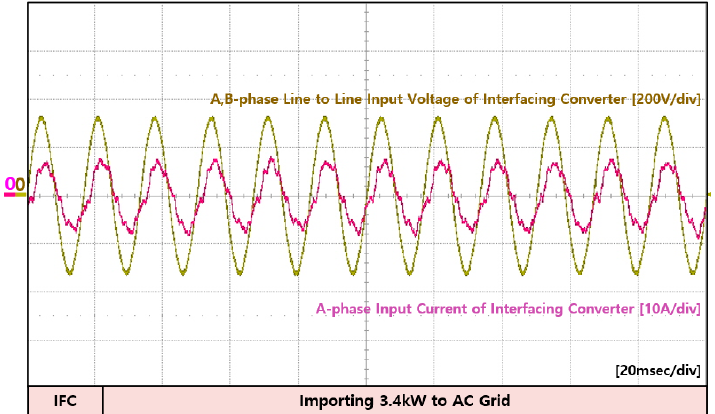
Figure 30. Experiment waveforms of interfacing converter and WT converter in mode 6.